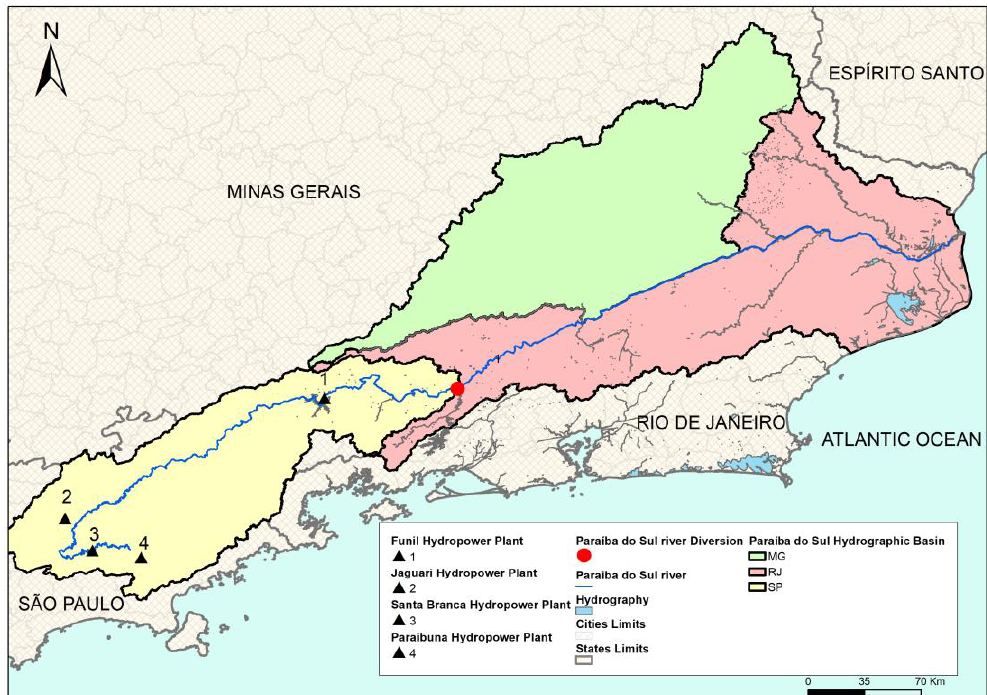
Figure 3. Paraíba do Sul River Basin. Figure 3. Para í ba do Sul River